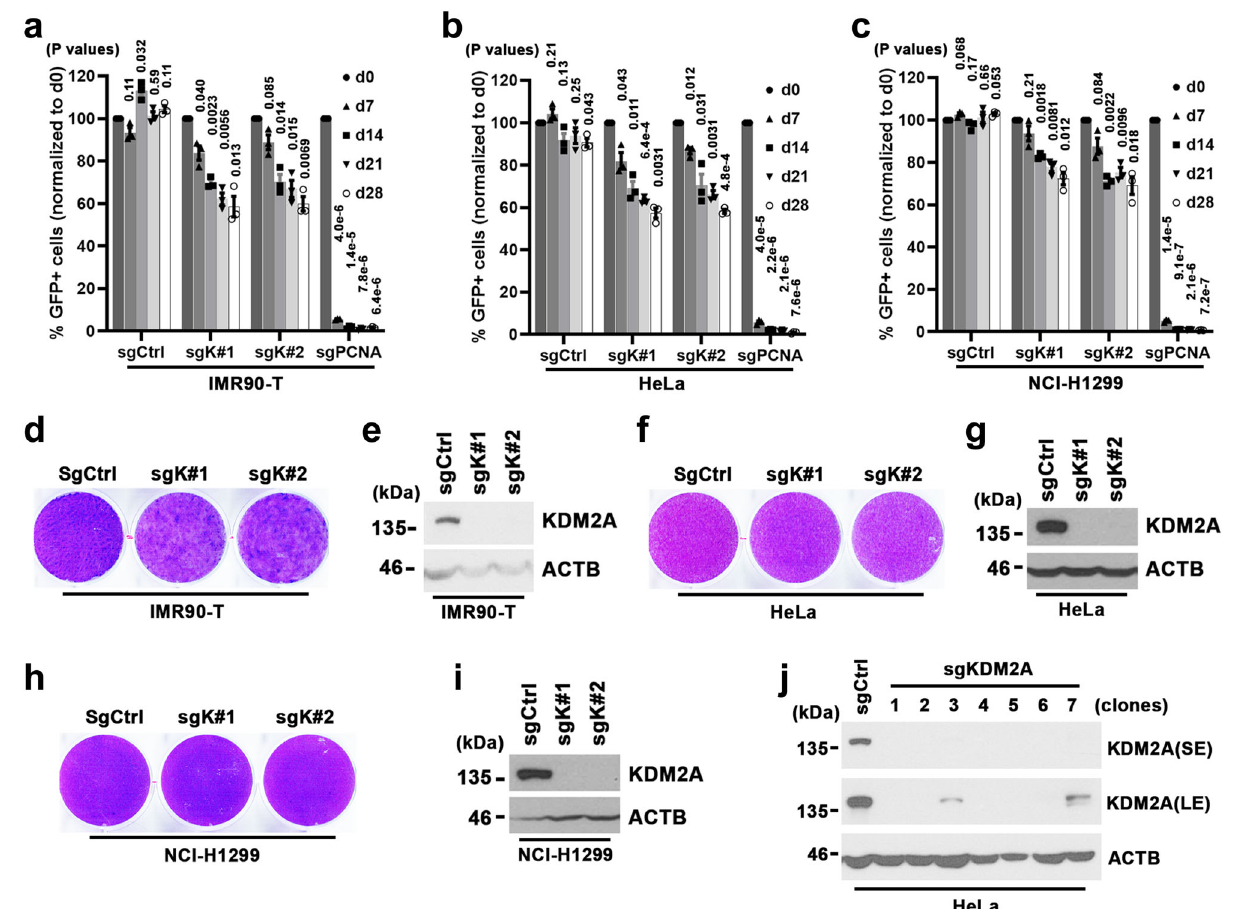
Fig. 2 | KDM2A is dispensable for non-ALT cells. a – c Competition-based pro- liferation assays of the indicated sgRNAs in IMR90-T ( a ), HeLa ( b ), or NCI-H1299 cells ( c ). A GFP reporter is linked to sgRNA expression. sgCtrl and sgPCNA were included as a negative or positive control, respectively. Data were expressed as mean ± s.e.m. of three independent experiments; two-tailed paired t -test. d , e Clonogenic assay ( d ) and KDM2A western blot analysis ( e ) of sgCtrl, sgK#1, or sgK#2-transduced IMR90-T cells. Crystal violet staining was conducted on day 22 post-seeding. f , g Clonogenic assay ( f ) and KDM2A western blot analysis ( g ) of sgCtrl, sgK#1, or sgK#2-transduced HeLa cells. Crystal violet staining